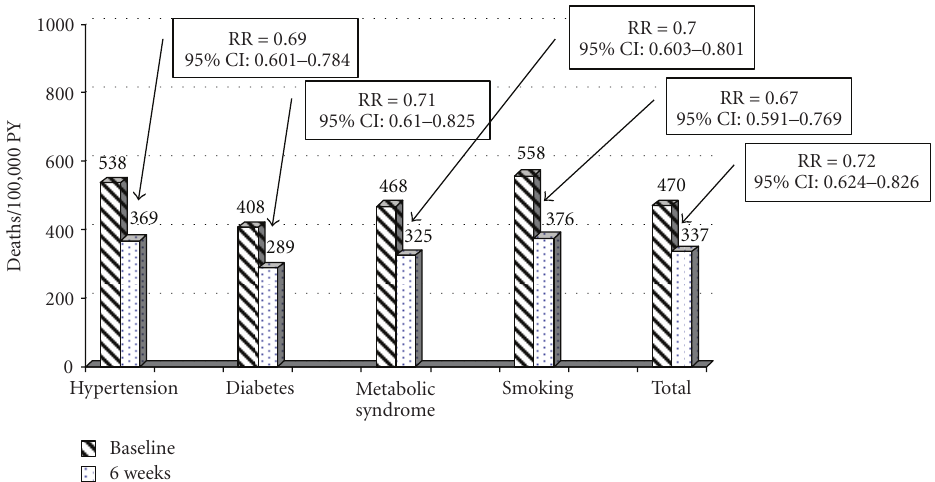
Figure 1: CHD Mortality (Estimated Deaths/100,000 PY). PY = person-years.